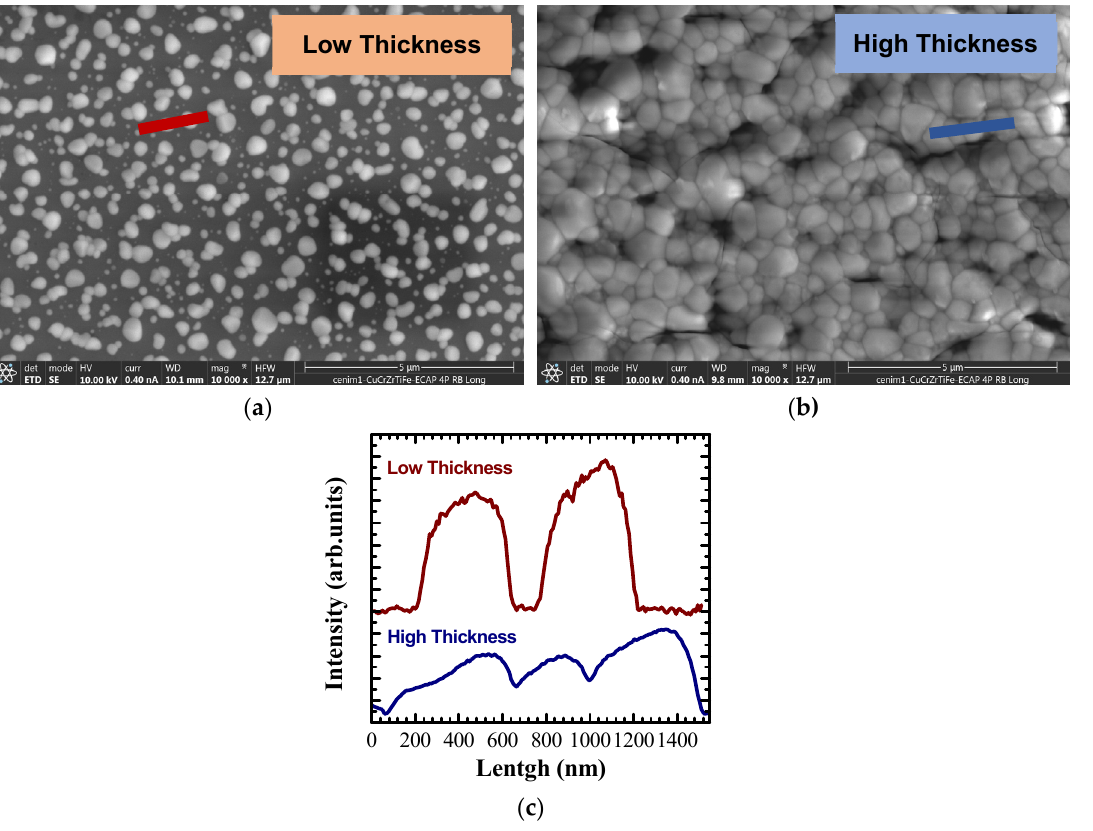
Figure 4. Plan-view SEM images of Nd-doped thin films: ( a ) low thickness; ( b ) high thickness. ( c ) Intensity profiles obtained from the straight line plotted in each image.